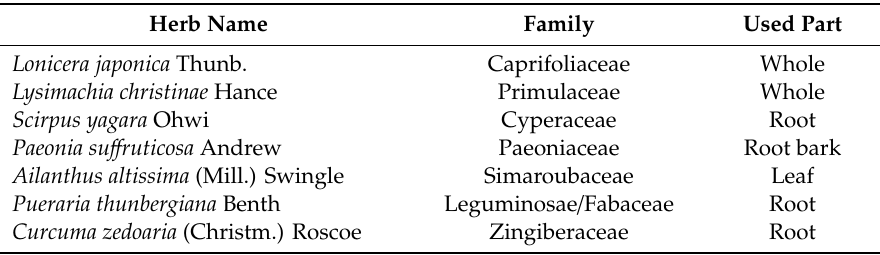
Table 1. Korean medicinal plants.